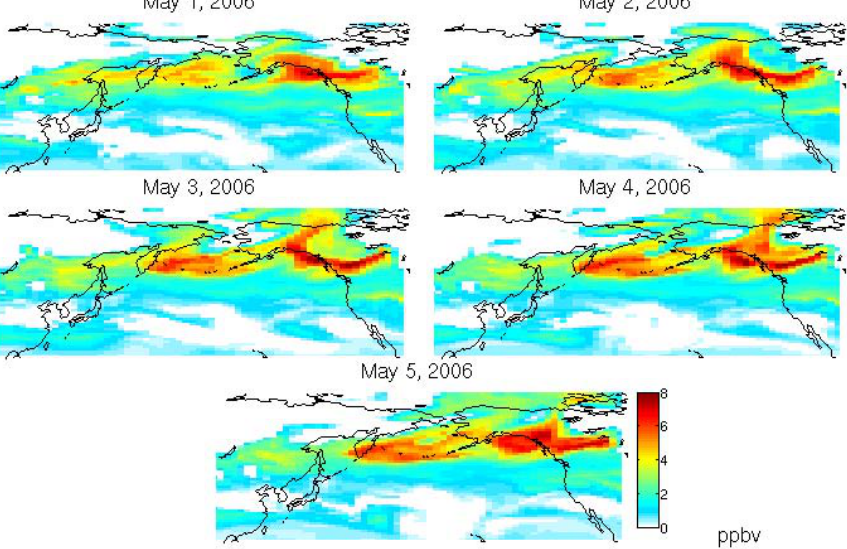
Fig. 16. Ozone due to transport of PANs from 1–5 May 2006. Panels show the contribution from PAN transport at 2km, obtained from difference between the baseline and “no PAN”